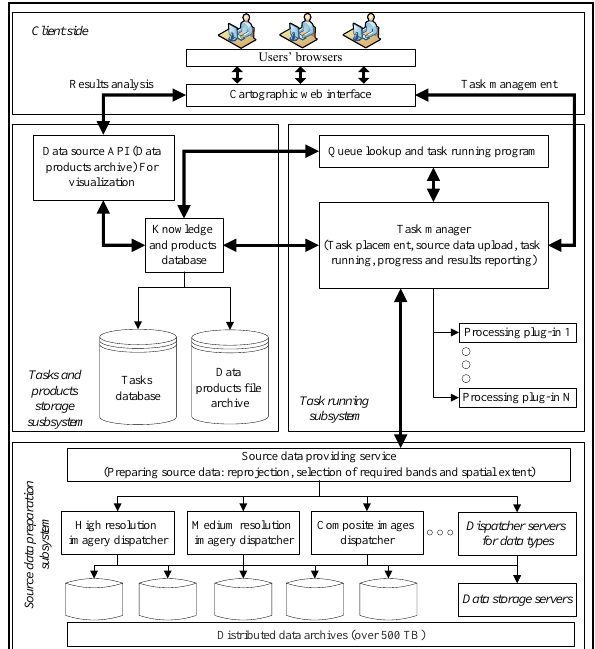
Figure 5. The principal scheme of GEOSMIS technology